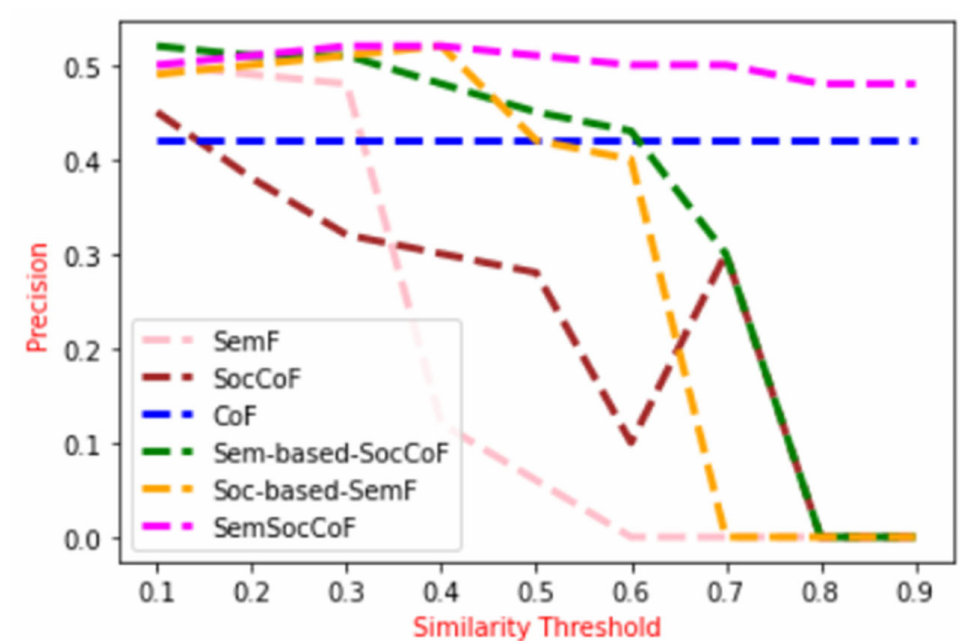
Figure 15. Comparison of precision values of various